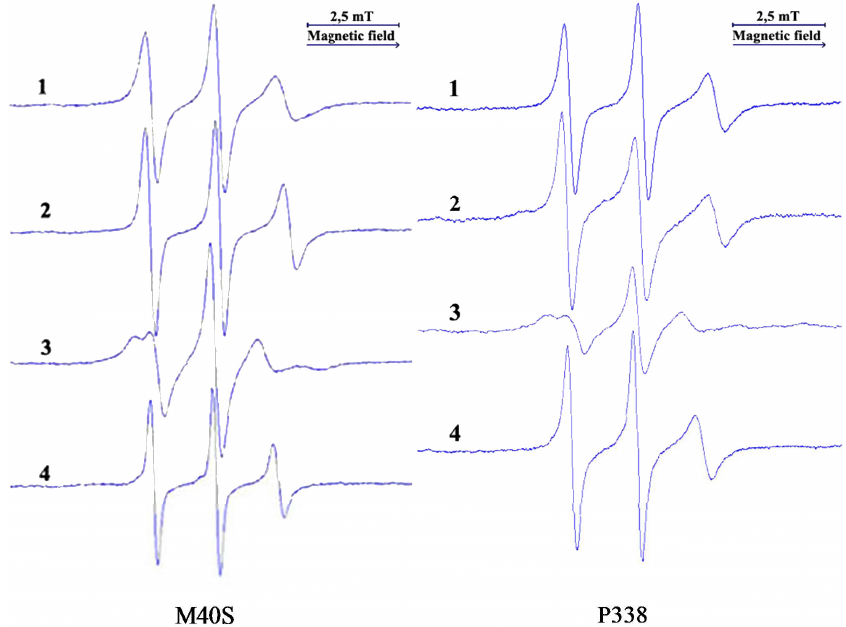
Fig. 15. EPR spectra of the spin probes in 7 % aqueous solutions of М40S and in 10 % aqueous solution of P338 at 25 °С: 1 – TEMPO-iodide; 2 – 4-palmitamido- TEMPO; 3 – 5-DSA; 4 –